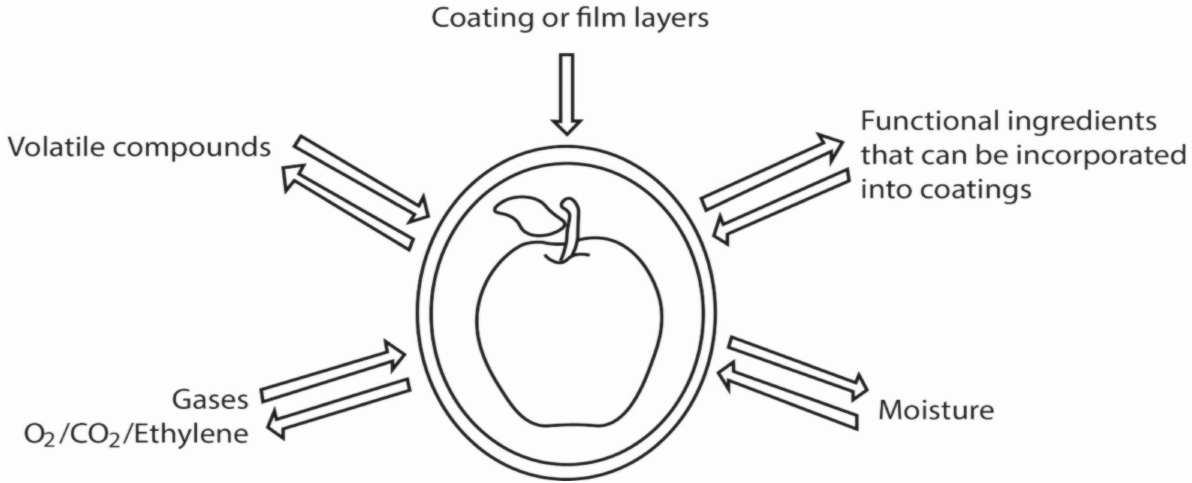
Figure 3. Types of transfers controlled by edible barriers in